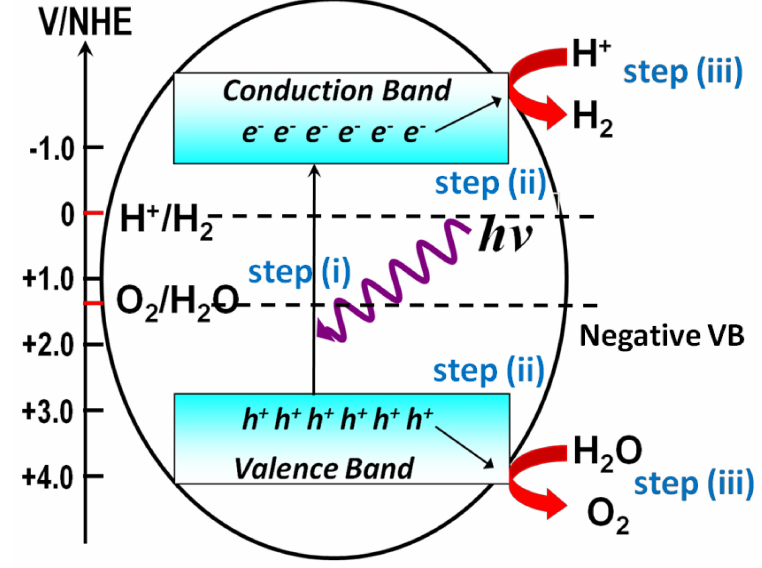
Figure 1. Schematic steps for solar H 2 production from photocatalytic water